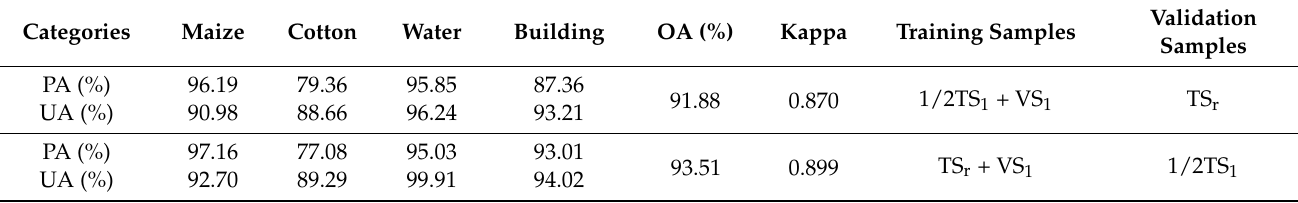
Table 8. Accuracies and Kappa coefficients of the classification of four land-cover types using 117 features and different training and validation samples. (TS 1 : the initial training samples presented in Table 2, 1/2TS 1 denotes a half of the initial training samples, TS r : the other half of the initial training samples, VS 1 : the initial validation samples presented in Table 2). Categories